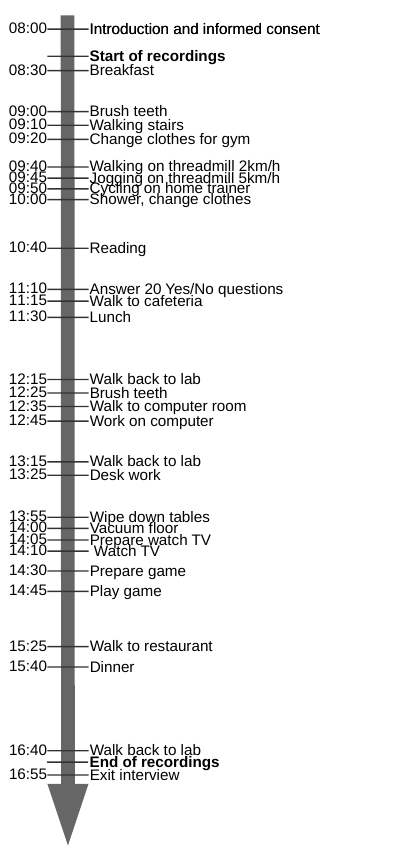
Table 1: Activity clusters and total duration. No Cluster Activity & total duration [min:sec] 1